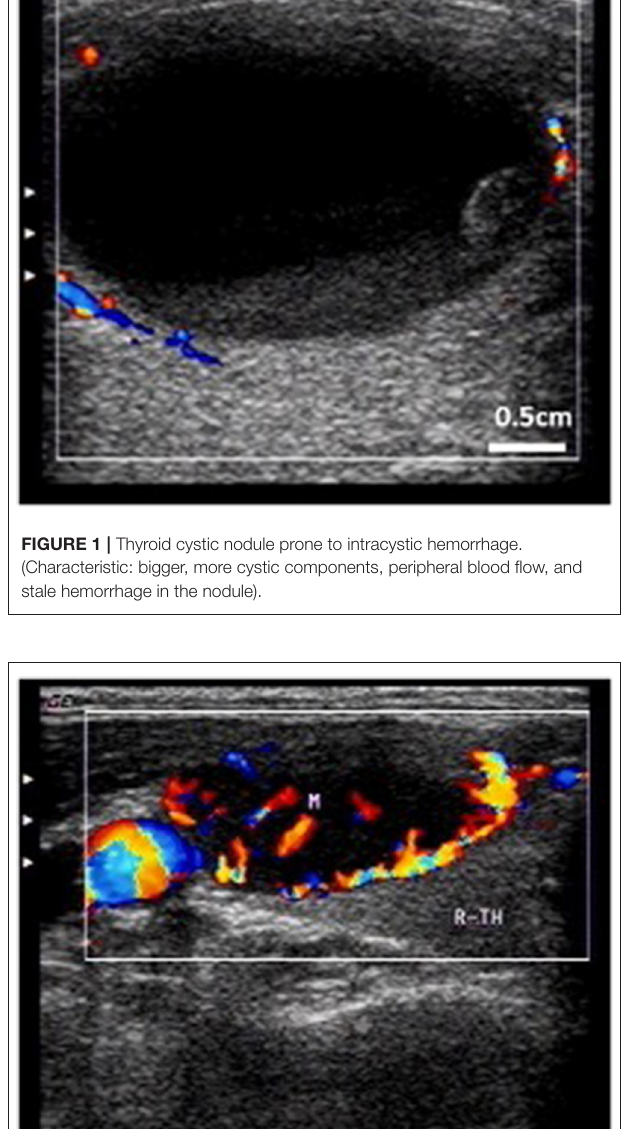
Intracystic Hemorrhage